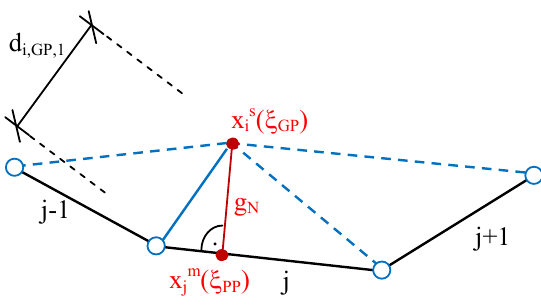
Figure 5: Find the closest master control point and correct